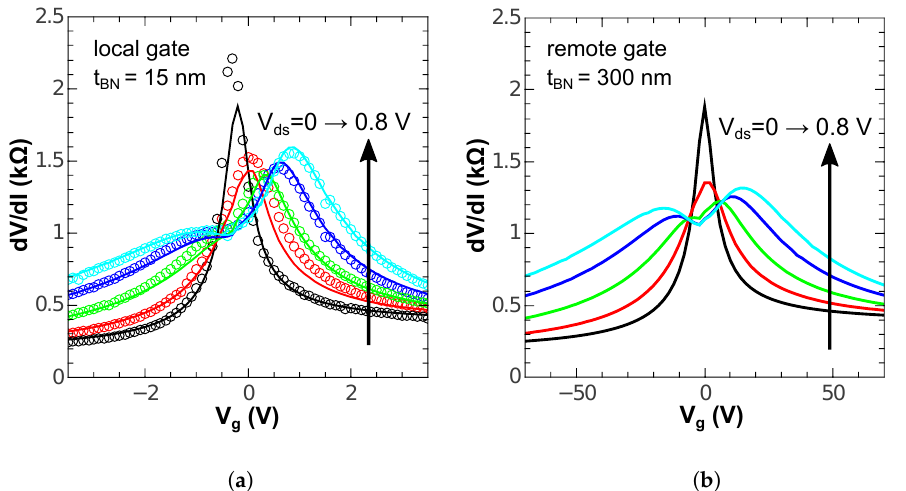
Figure 5. ( a ) Small signal resistance of the transistor obtained from the model (solid lines) and from the measured scattering parameters of sample-A at 2 GHz (circles). ( b ) Small signal resistance simulated for a remote gate transistor (h-BN dielectric thickness of 300 nm). The saturation effect is enhanced for the local gate device in the n-doping